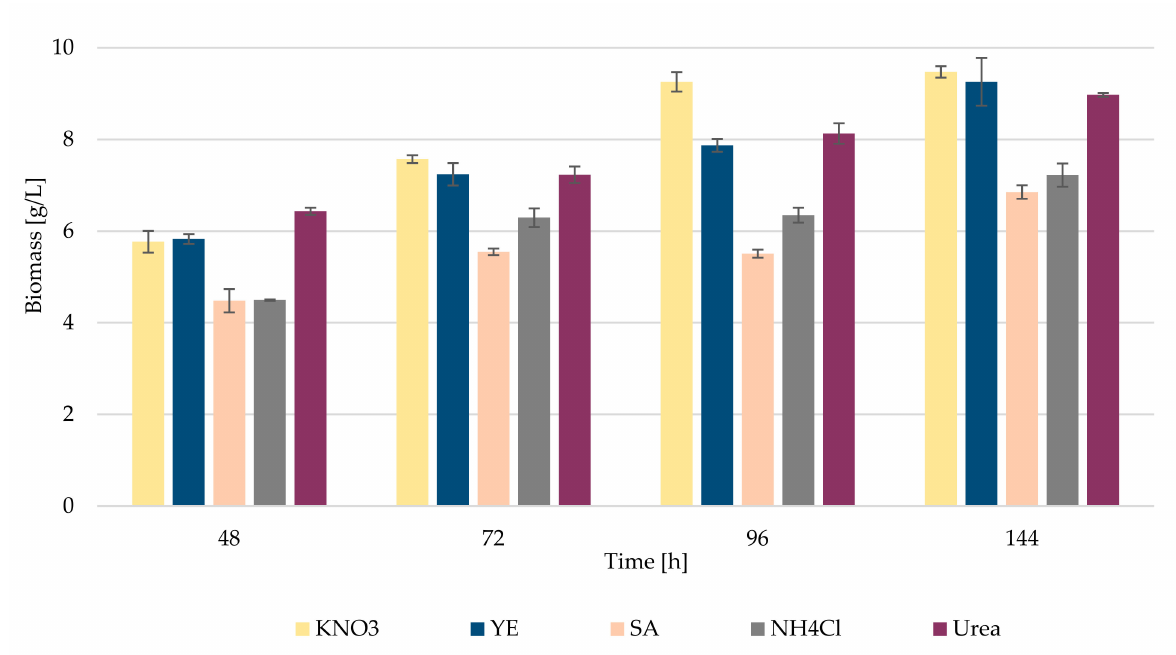
Figure 1. Biomass production by R. kratochvilovae CCY 20-2-26 cultivated in the presence of various nitrogen sources. Table 5. Biomass composition of R. kratochvilovae CCY 20-2-26 cultured on different nitrogen sources.